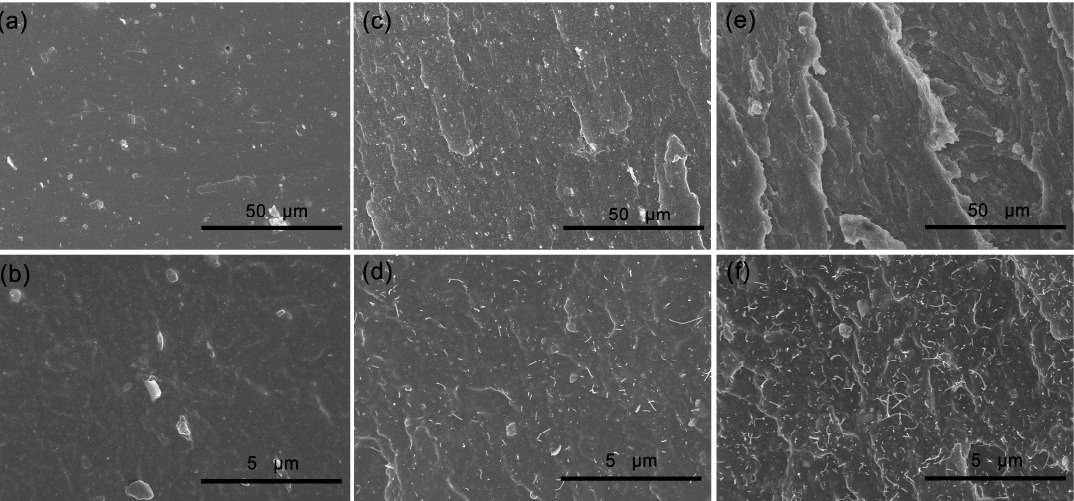
Figure 6. SEM images of tensile fractured surface for aged EPDM composites (aging condition: 150 °C × 72 h): ( a , b ) C0; ( c , d ) C4; ( e , f ) C10.